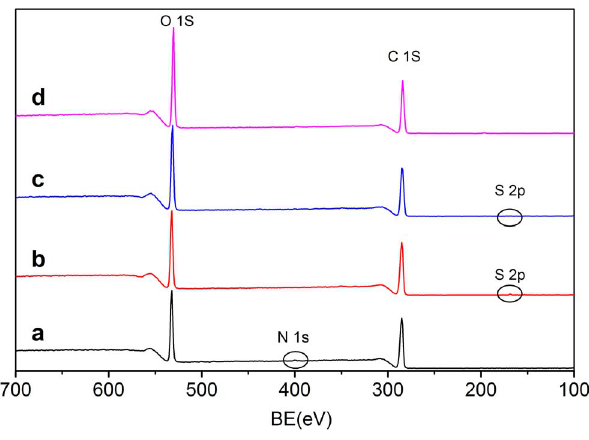
Figure 1. General XPS spectra of (a) WMS, (b) SNC H2SO4,3 , (c) SNC H2SO4,7 , and (d) SNC HCl,7 .